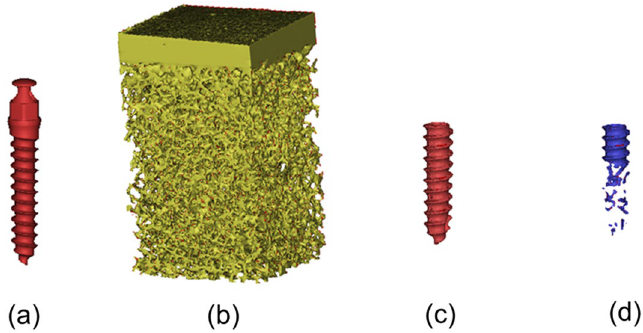
Figure 7. ( a ) 3D model of the orthodontic miniscrew, ( b ) 3D model of a small region of a bovine iliac bone specimen, ( c ) exterior surface of the orthodontic miniscrew inside a bone specimen (pBMCA), and ( d ) real bone–miniscrew contact area